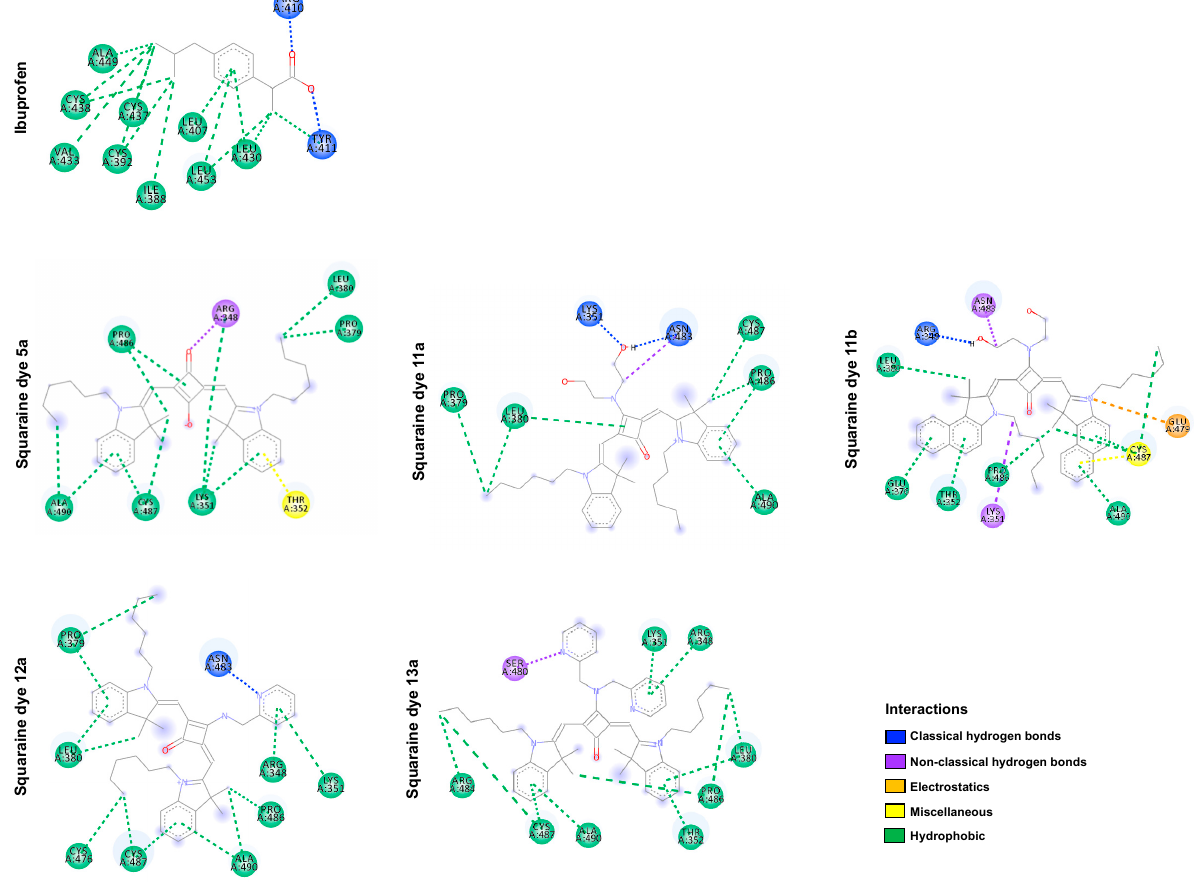
Figure 5. Binding modes and interactions of ibuprofen and squaraine dyes 5a , 11a , b , 12a , and 13a with amino acid residues of human serum albumin protein at Sudlow site II.